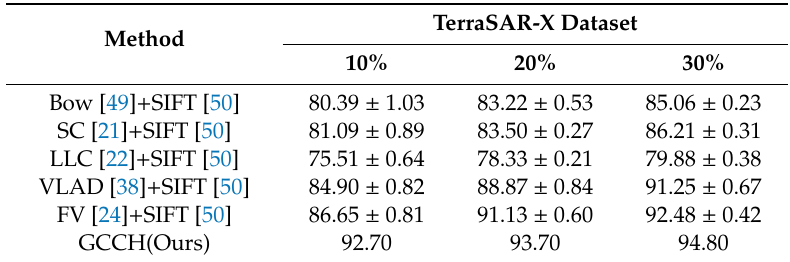
Table 4. Comparison with other mid-level feature representation